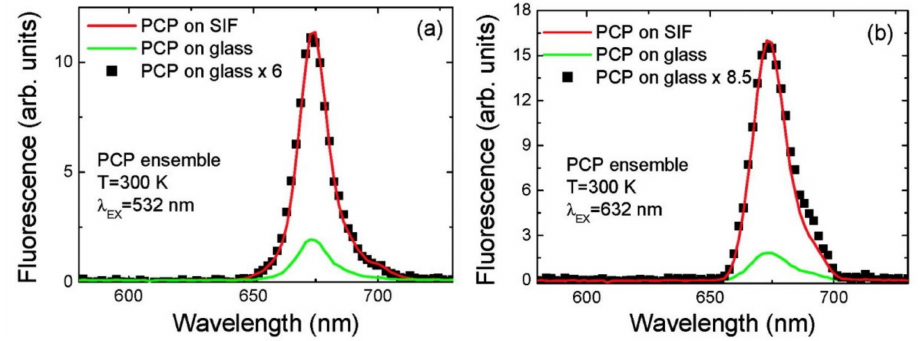
Figure 4. ( a ) Average fluorescence emission spectra measured for PCP ensembles on bare glass (green) and SIF-coated coverslips (red) excited at 532 nm. Black points correspond to the spectrum measured for PCP on glass multiplied by a factor of six. ( b ) Average fluorescence emission spectra measured for PCP ensembles on bare glass (green) and SIF-coated coverslips (red) excited at 632 nm. Black points correspond to the spectrum measured for PCP on glass multiplied by a factor of 8.5. “Reprinted (adapted) with permission from [20]. Copyright (2020) American Chemical